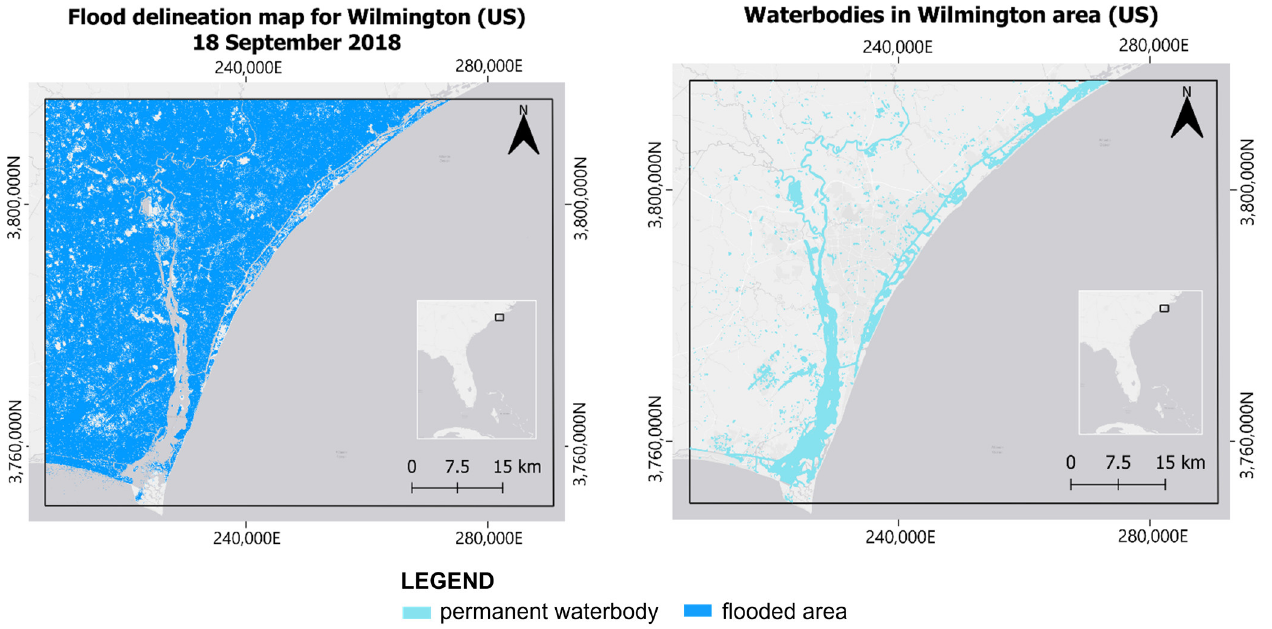
Figure 11. Flood delineation map ( left panel ) and permanent waterbodies map ( right panel ) for the Wilmington area (US). CRS: WGS84/UTM zone 18N. Basemap data: Esri Gray (light) © Esri.